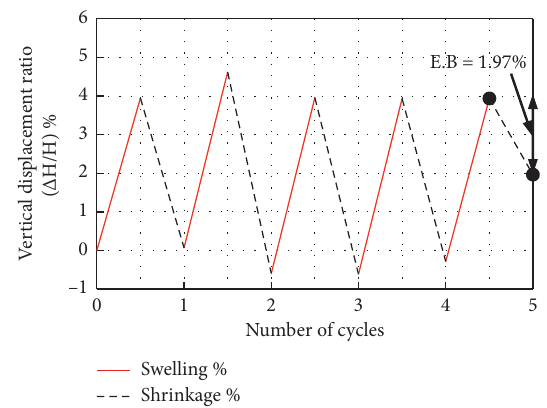
Figure 6: Vertical displacement ratio versus the number of cycles for